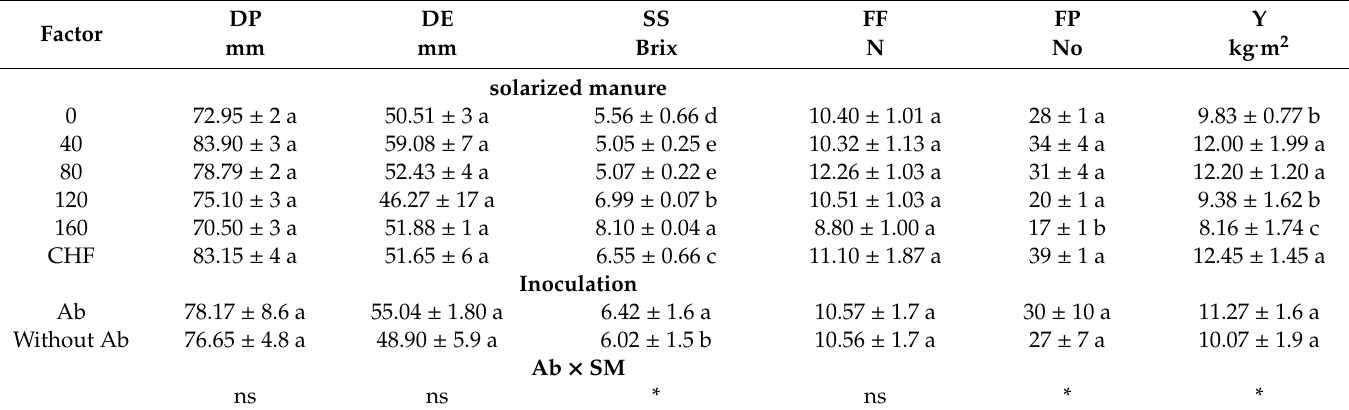
Table 5. E ff ect of Azospirillum brasilense (Ab), solarized manure, and interaction (Ab × SM) on polar diameter (DP), equatorial diameter (DE), soluble solids (SS), fruit firmness (FF), fruits per plant (FP) and yield (Y: kg . m 2 ) on tomato